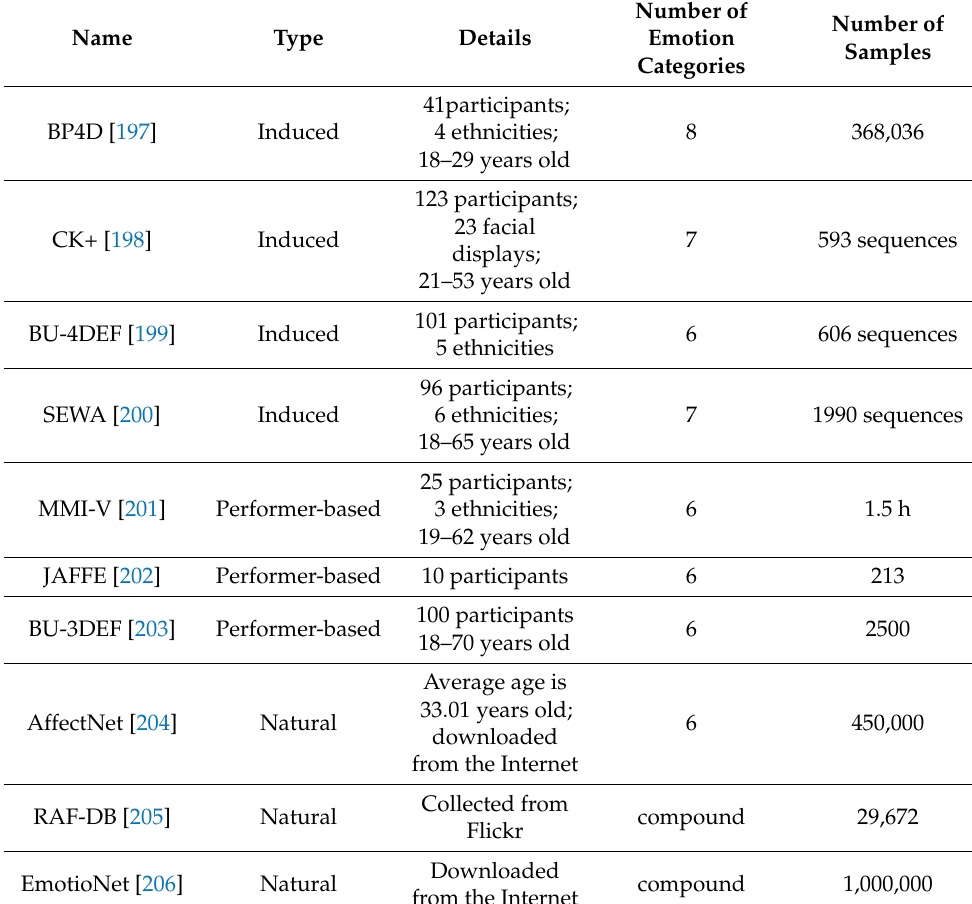
Table 4. Datasets for facial expression recognition.